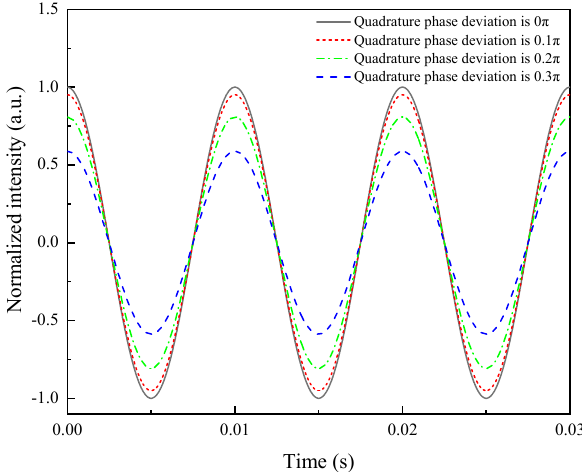
Figure 6. Demodulation effect of signals with different quadrature phase deviations.